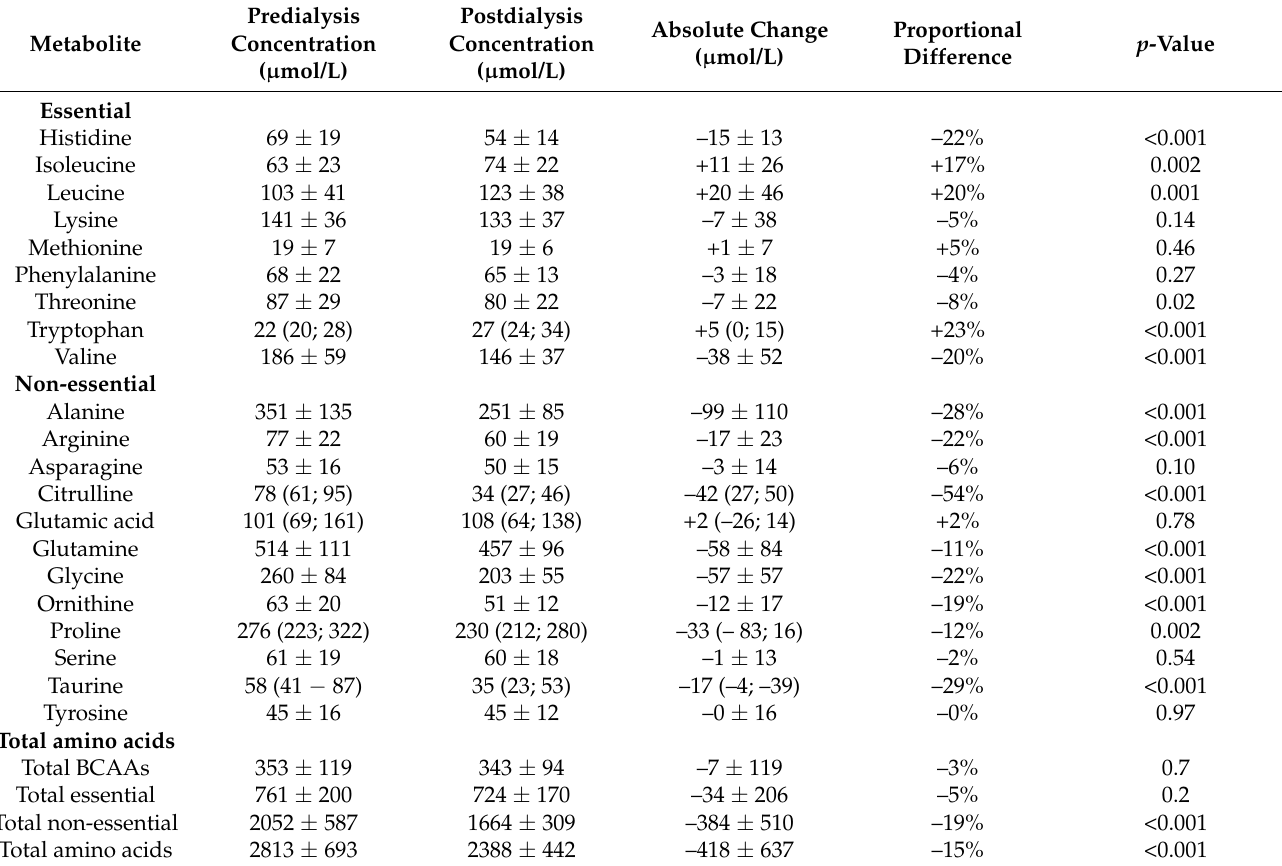
Table 4. Overview of intradialytic changes in plasma amino acid concentrations in hemodialysis